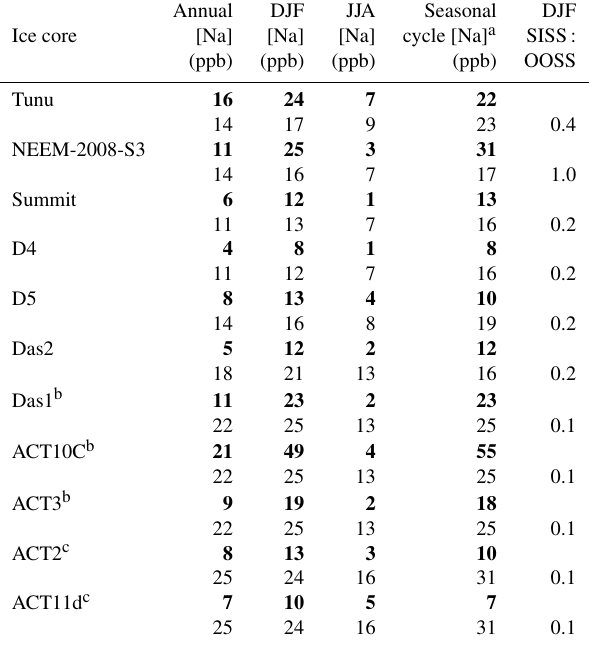
Table 4. Mean sea salt Na concentrations for 1991–1999 recorded in ice cores (bold) and simulated by p-TOMCAT calculated using modelled precipitation rates in Eq. (5). See Table S1 for equivalent values calculated using ice core snow accumulation rates.